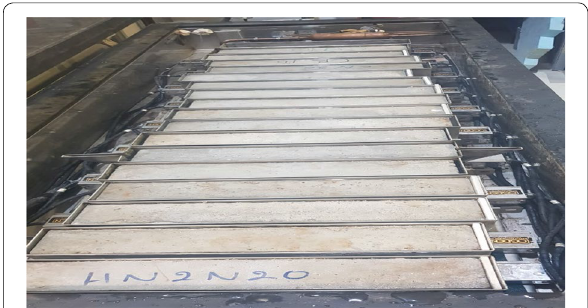
Fig. 10 View of specimens prepared for freeze thaw cycles.